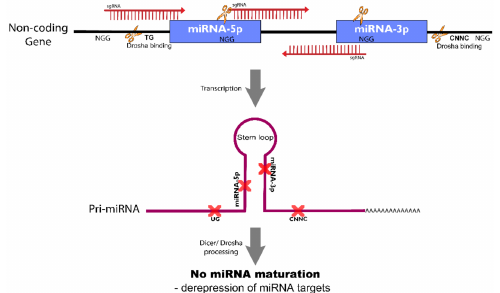
Figure 7. Editing non-coding genes with CRISPR/Cas9. Targeting non-coding genes with CRISPR/Cas9. In the figure the non-coding miRNA gene is represented and the sgRNAs target structural regions of the primary miRNA structure that are necessary for miRNA processing by DROSHA and DICER